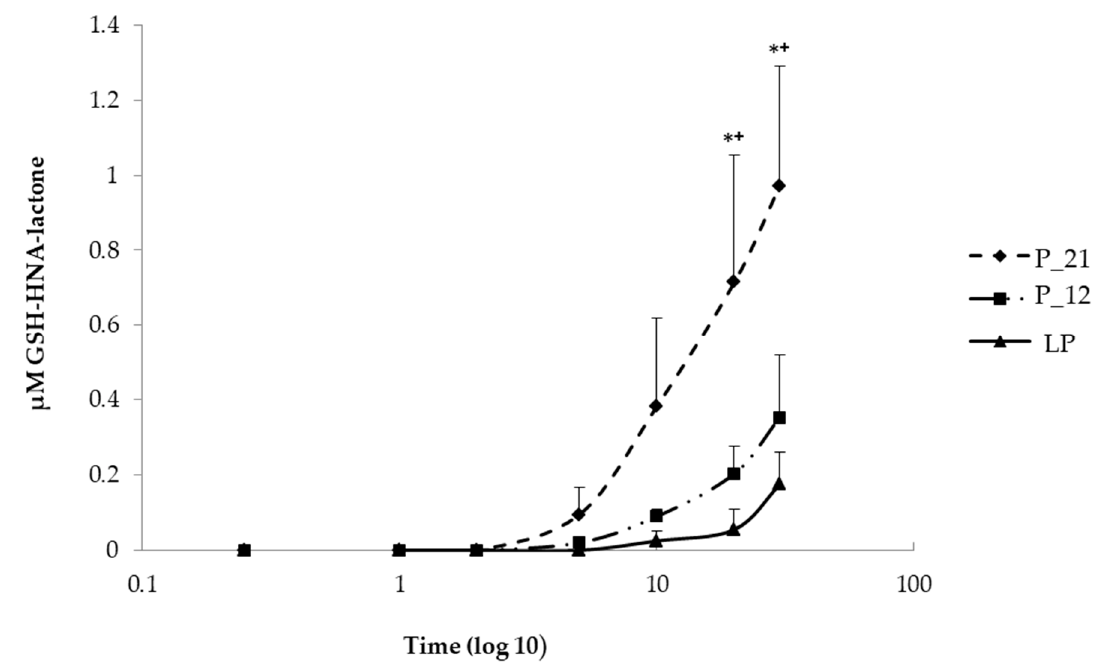
Figure 4. Comparison of the kinetics of GSH, 4-hydroxynonenoic acid, and lactone (GSH-HNA-lactone) formation at early (P-21), middle (P-12), and last passage (LP) in extracellular media taken in di ff erent time points (0, 15 s, 1 min, 2 min, 5 min, 10 min, 20 min, and 30 min) after the addition of HNE. Data are presented as means ± SD (P-21 and P-12 n = 4, LP n = 3). Statistically significant di ff erences are marked with * p < 0.05 when P-21 is compared with LP and + p < 0.05 when P-21 is compared with P-12 as analyzed by Student’s two-tailed t-test for independent samples. The results indicate that the formation of GSH-HNL differs depending on the passage number.